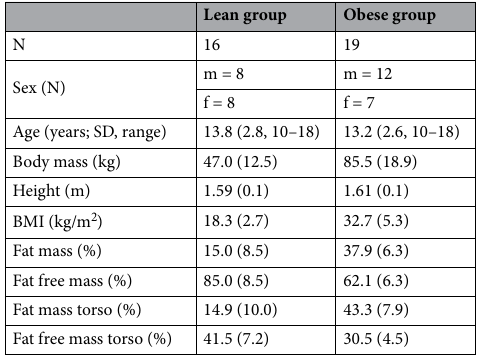
Table 1. Overview of the study sample’s characteristics. Values are reported as mean (SD), unless otherwise stated.